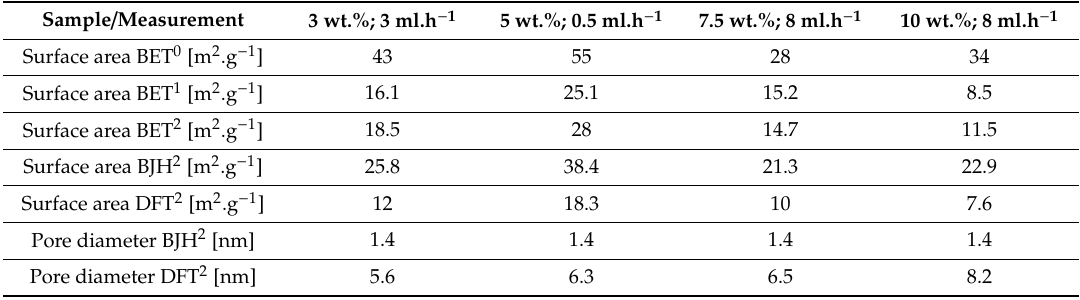
Figure 6. Adsorption/desorption Isotherms. ( A ) 3 wt.%; 3 ml.h − 1 , ( B ) 5 wt.%; 0.5 ml.h − 1 , ( C ) 7.5 wt.%; 8 ml.h − 1 , ( D ) 10 wt.%; 8 ml.h − 1 .